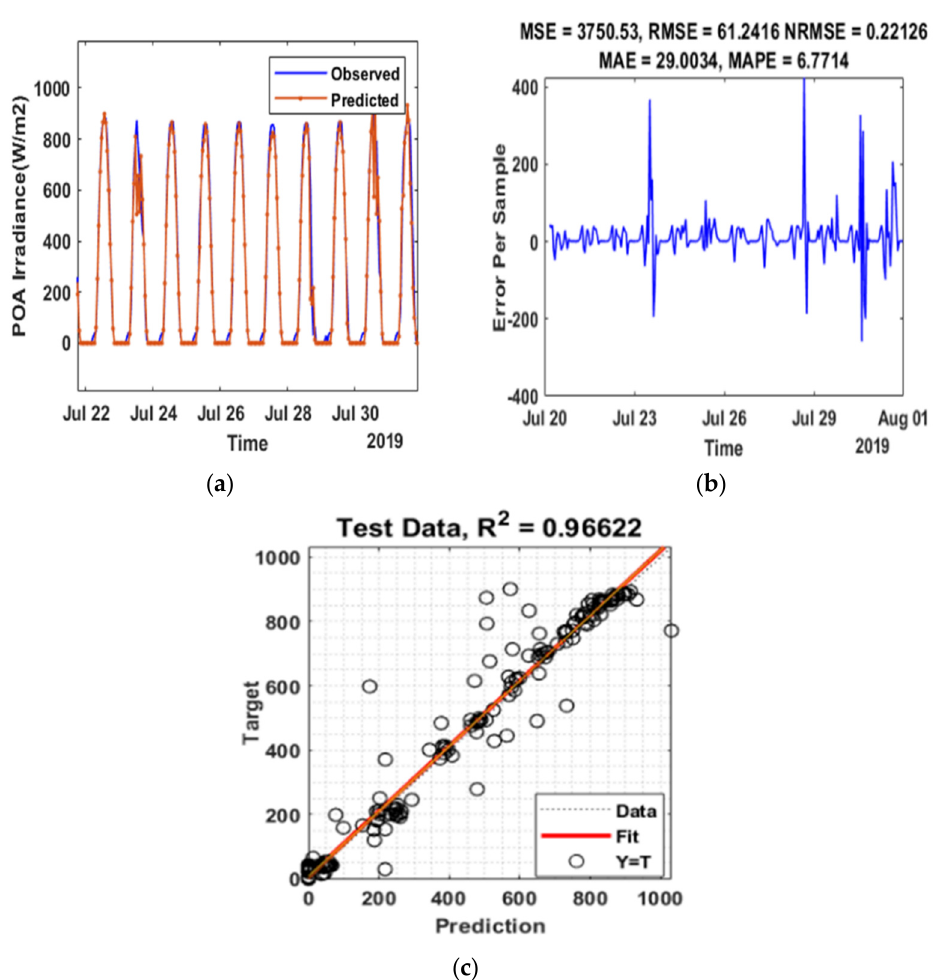
Figure 11. ( a ) The observed and predicted results, ( b ) error metrics and ( c ) regression plot considering POA—Sweihan photovoltaic independent power project, Abu Dhabi, for Multistep CNN-stacked LSTM.